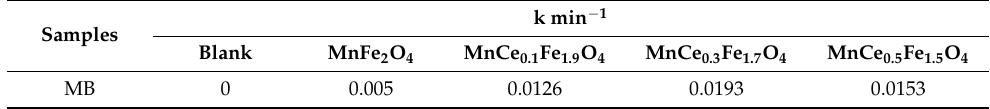
Figure 9. Pseudo-first-order kinetic plot for MB dye degradation using spinel MnCe x Fe 2 − x O 4 (x = 0.0, 0.1, 0.3 and 0.5) NCs. Table 4. Rate of constant k abs value for the degradation of RhB on spinel MnCe x Fe 2 − x O 4 (x = 0.0, 0.1, 0.3 and 0.5)